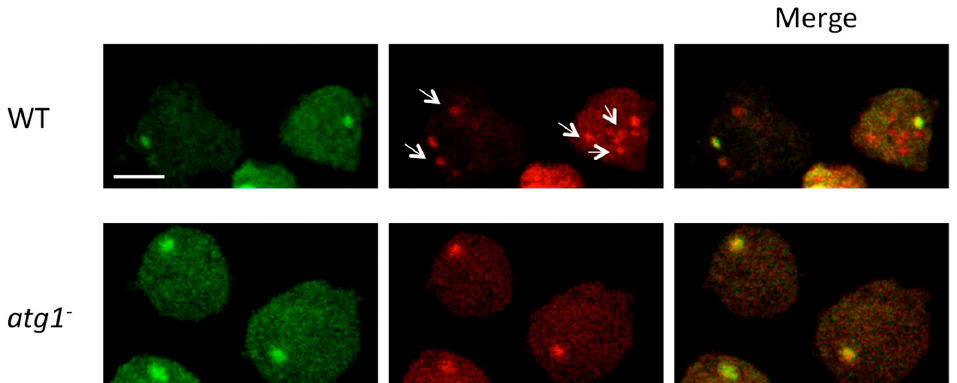
Figure 6. Wild-type (WT) (AX4) and atg1 - cells expressing the marker RFP-GFP-Atg8 were incubated for four hours with two pulses of 100 mM NH 4 Cl and visualized by confocal microscopy. The arrows show the presence of red-only puncta in WT that presumably represent autophagolysosomes. Cells lacking Atg1 typically show a large aggregate and no red-only puncta. Scale bar 5 µm.